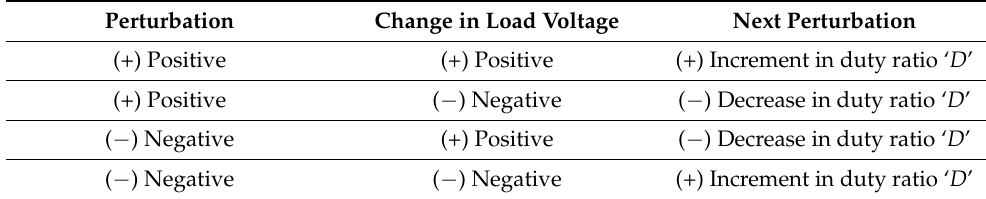
Table 2. Methodology of the proposed method.